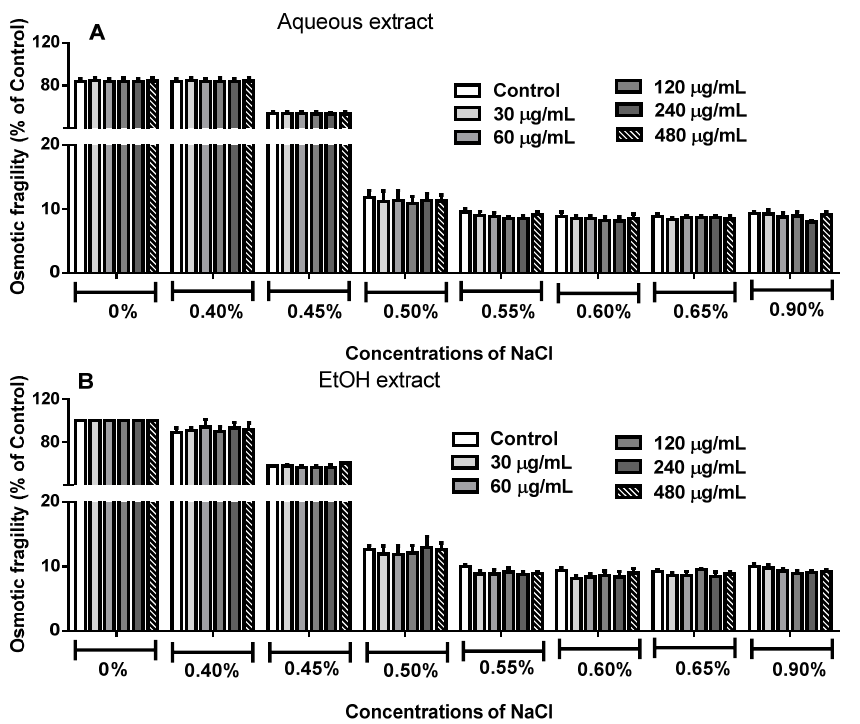
Figure 7. Osmotic fragility of human erythrocytes treated with aqueous ( A ) and ethanolic ( B ) extracts of the leaves of R. echinus . Untreated and treated erythrocytes were added to different concentrations of NaCl (0%–0.9%) and incubated for 20 min. The absorbance of the supernatant was measured and the hemolysis in each tube was expressed as percentage of control. Each bar represents the mean of n = 3 independent experiments performed in triplicate ± SEM.